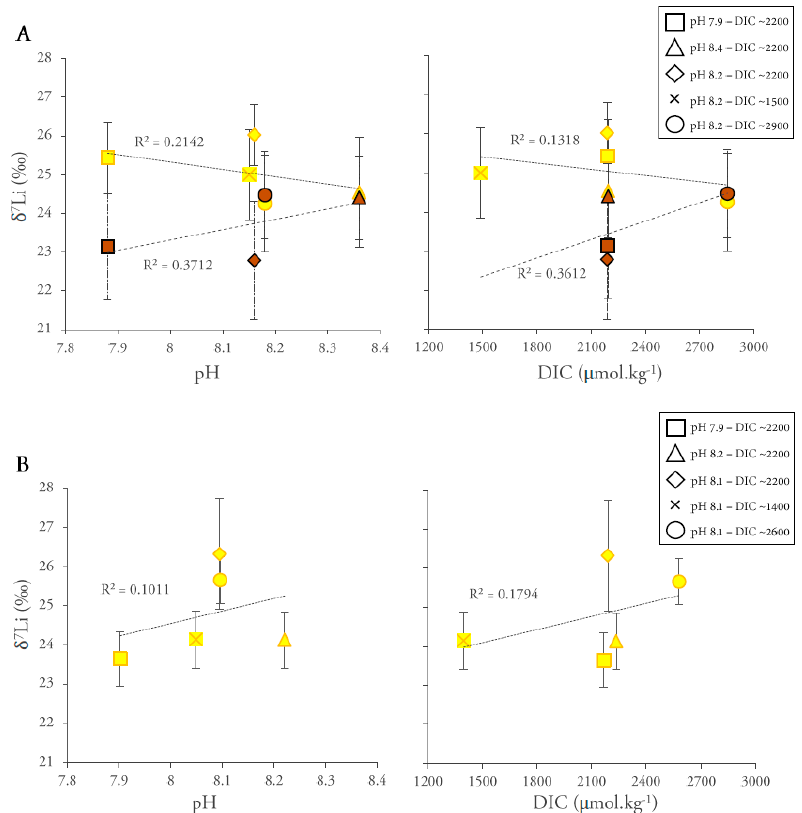
Figure 1. δ 7 Li values in Amphistegina lessonii tests as a function of pH (left panels) and DIC (right panels). ( A ) Normal seawater; ( B ) ×5 Li-enriched seawater. Yellow symbols—light/dark cycles. Brown symbols—dark only. Note that δ 7 Li values in the specimens grown under low DIC and dark treatment in experiment 1 could not be measured (see text for details). The error bars for δ 7 Li represent the external error (2 σ ). Errors for pH and DIC are negligible (and smaller than symbol size).